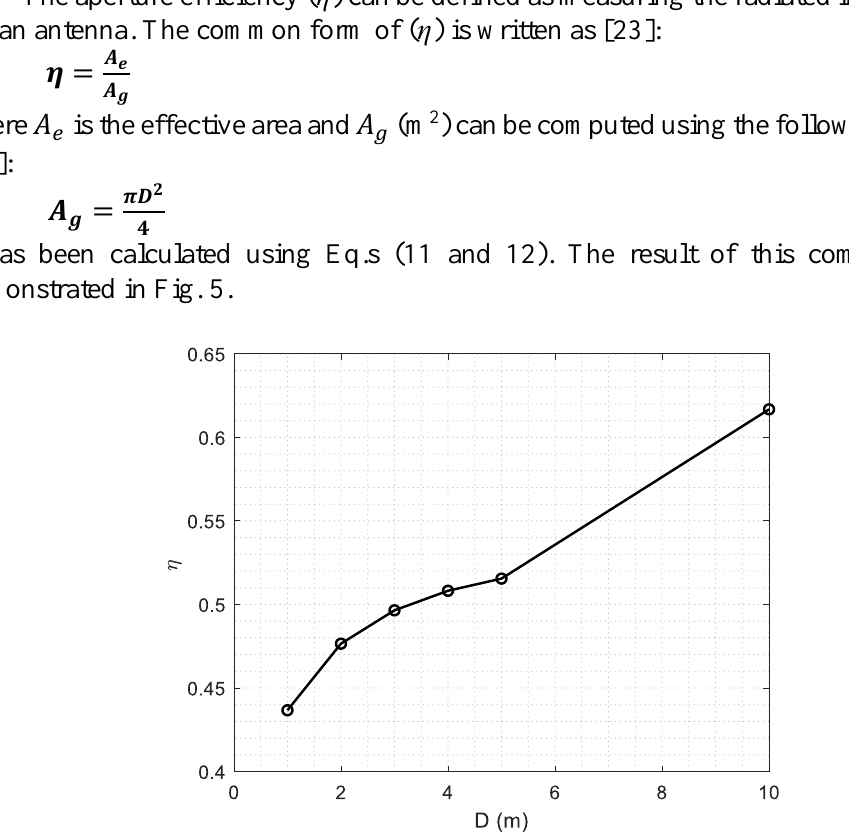
Figure 5: Aperture efficiency (η) as a function of the antenna diameter (D)